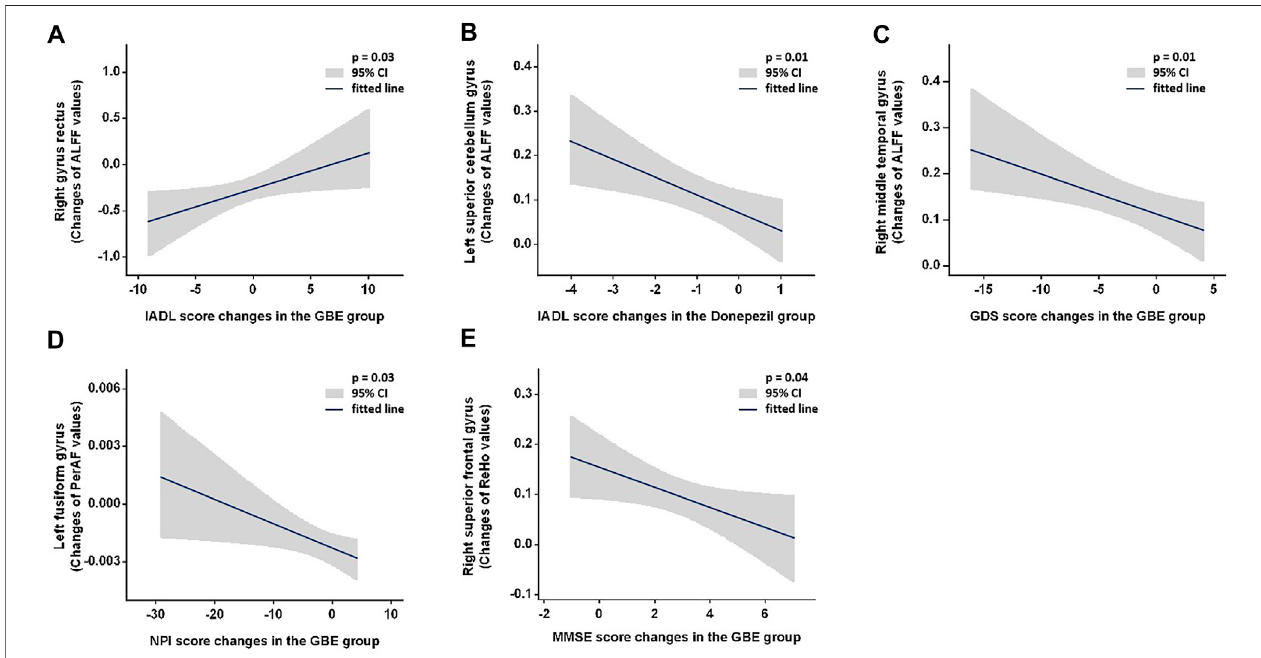
FIGURE 3 | Demonstration of signi fi cant correlations between changes of neuropsychological function and fMRI metrics. GBE: Ginkgo biloba extract; ALFF: amplitude of low frequency fl uctuation; PerAF: percent amplitude of fl uctuation; ReHo: reginal homogeneity; IADL: instrumental activity of daily living; GDS: geriatric depression scale; NPI: neuropsychiatric inventory; MMSE: minimum mental state examination.